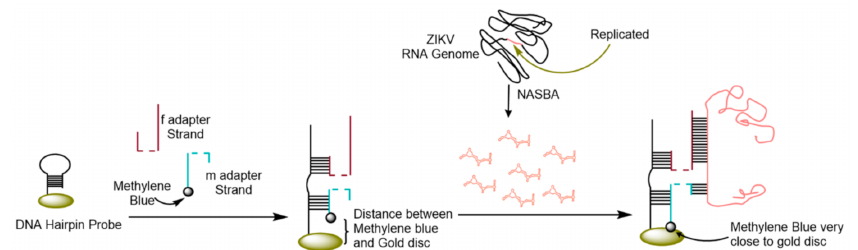
Figure 7. Fabrication of a four-way junction (4WJ) electrode using a gold disc electrode, a DNA hairpin probe, and two adaptor strands complementary to the hairpin probe. A specific section of ZIKV RNA genome is replicated by NASBA and it is also complementary to the adaptor strands. The binding of adaptor sequence and ZIKV RNA brings methylene blue redox label closer to gold disc electrode, increasing the detected current. Adapted from Lynch et al. [118] with permission from